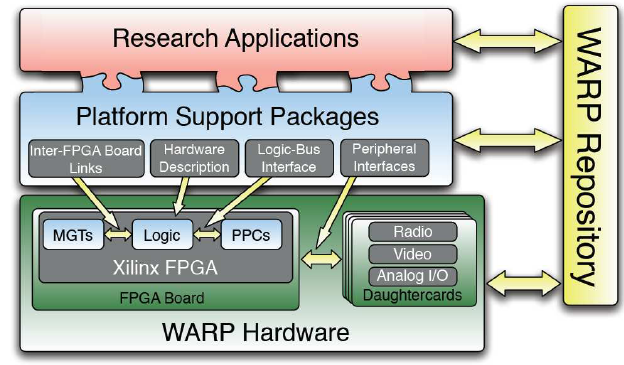
Figure 16. Architecture of the WARP platform.